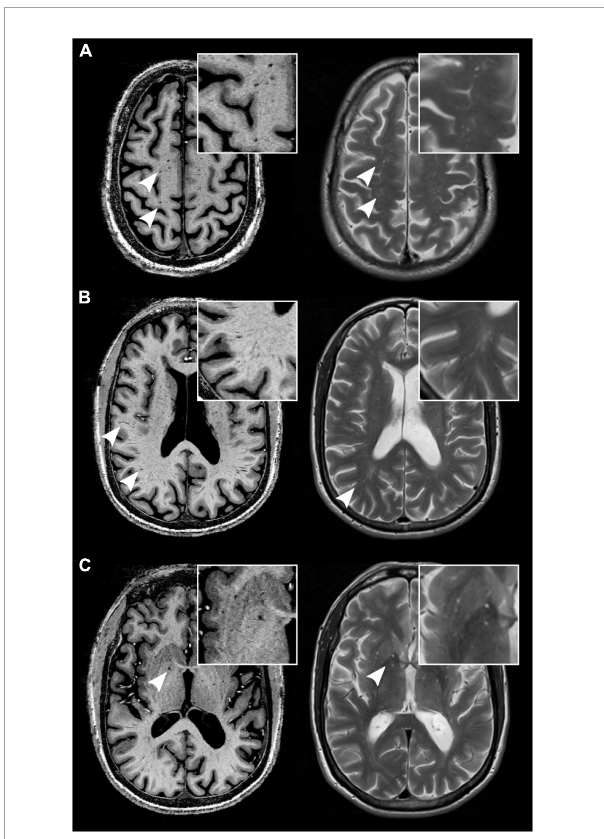
FIGURE1 MRI-visible perivascular spaces (MVPVS) on magnetic resonance imaging (MRI). MVPVS are isointense to cerebrospinal fluid (CSF) on MRI on both T1 w (left column, acquired at 7-tesla static magnetic field strength) and T2 w/PD sequences (right column, acquired at 3-tesla static magnetic field strength) (white arrowheads). They commonly occur in the centrum semiovale (A) , deep white matter (B) , and basal ganglia (C) . Insets show higher magnifications. All images have an isotropic voxel size of 0.5